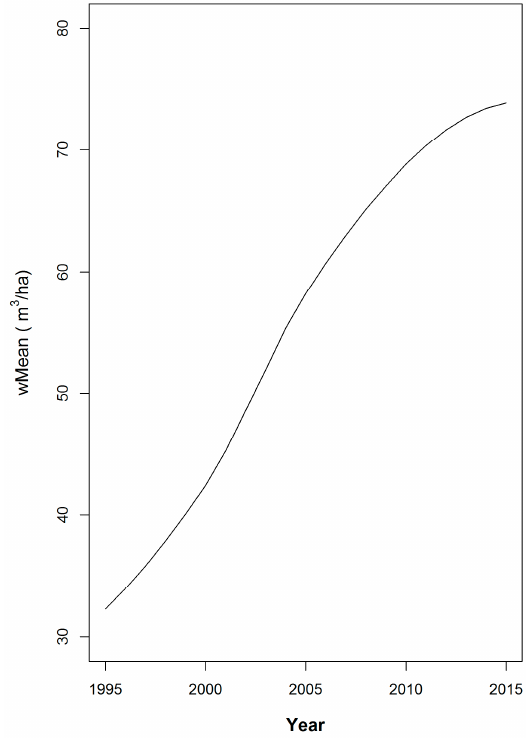
Figure 2. The weighted mean volume for the 152 populations from 1995 through 2015.